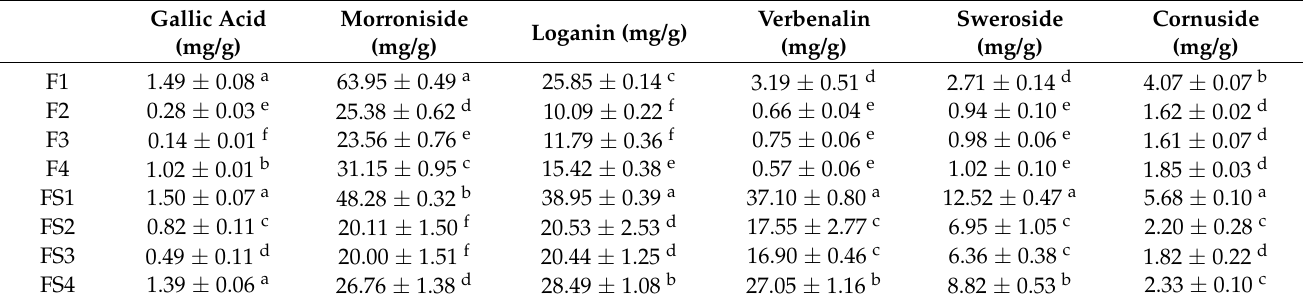
Table 4. Major components of Cornus officinalis fruit